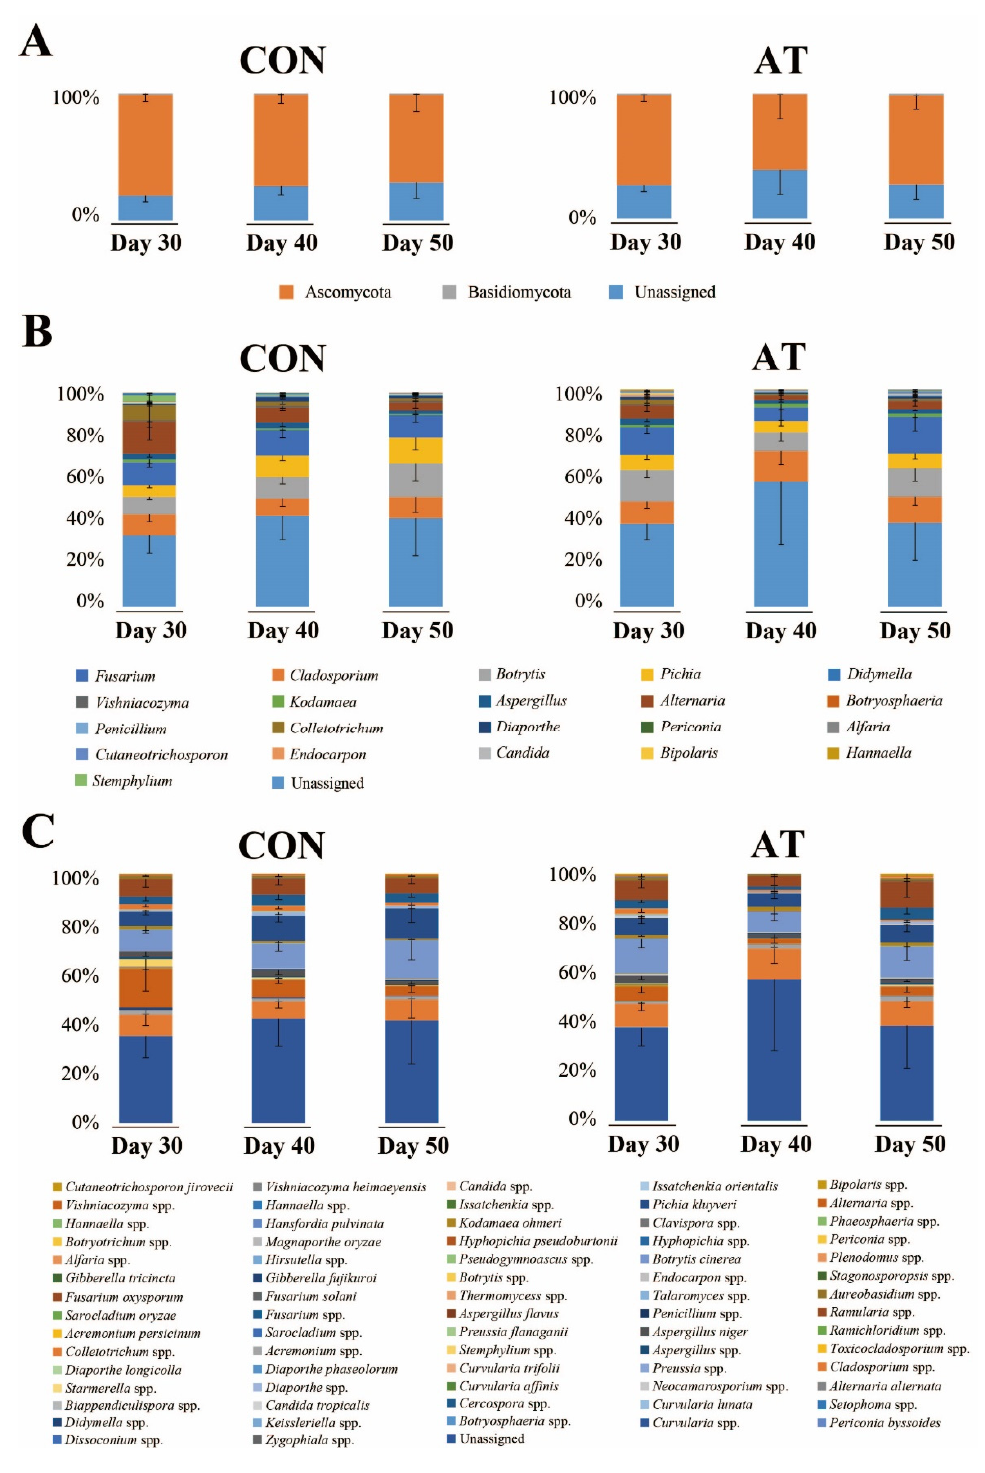
Figure 1. The kimchi fungal community profiles at the phylum ( A ), genus ( B ), and species ( C ) levels in the control group (CON) and the ampicillin-treated group (AT) during 30 to 50 days of fermentation as revealed by internal transcribed spacer 2 (ITS2) sequencing. The x-axis represents different samples. The y-axis represents the percentage abundance of fungus in each sample.